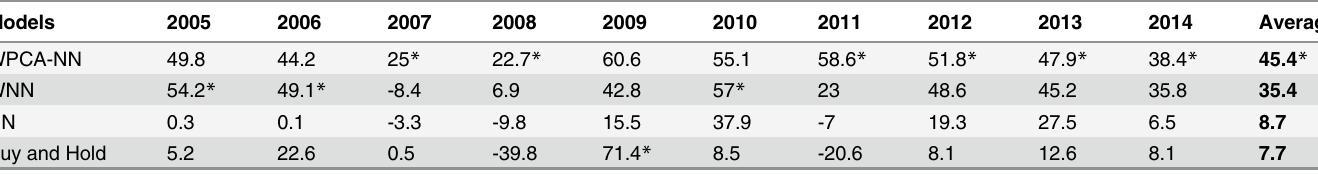
Table 12. Profit of the models, results for TAIEX futures. Models